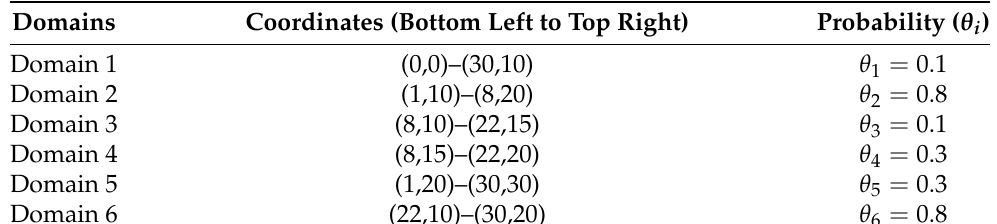
Table 1. The parameters of the generated data matrix.